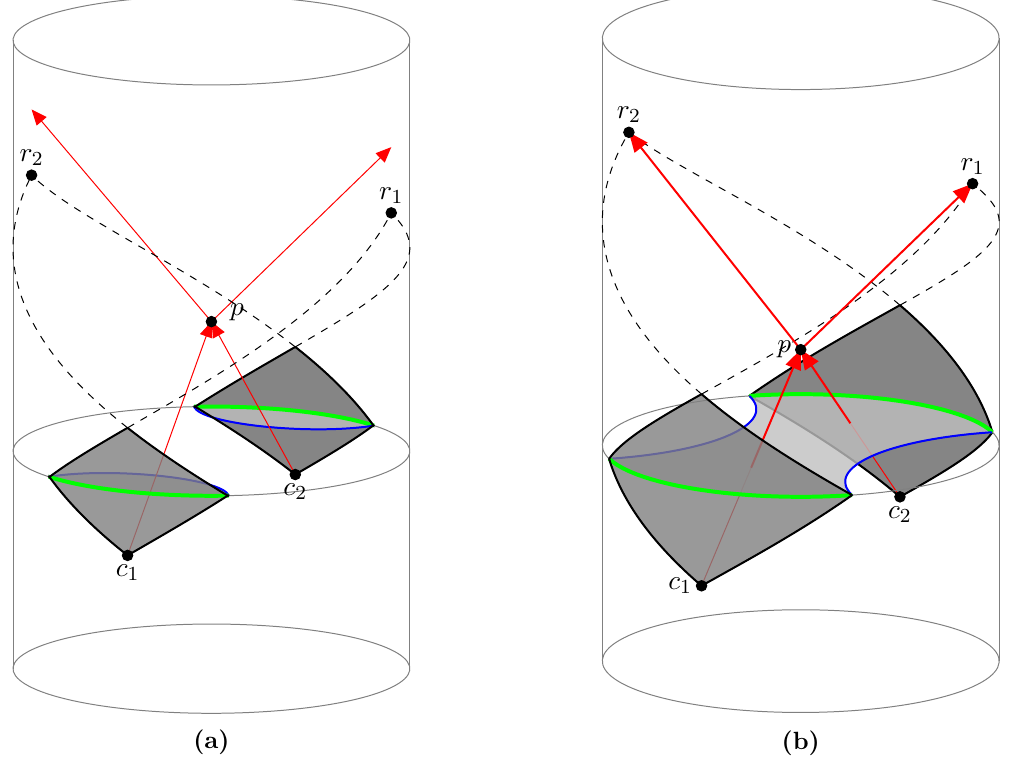
Figure 2. Combining our requirement on asymptotic quantum tasks, insights from quantum cryptography, and the Ryu-Takayangi formula we arrive at a precise result that applies to asymp- totically AdS spacetimes with holographic descriptions: whenever the minimal surface enclosing R 1 R 2 is given by the union of the minimal surfaces separately enclosing R 1 and R 2 , the intersection of four lightcones becomes non-empty. The regions R 1 and R 2 are shown in green. Their domain of dependence de(cid:12)nes the points c 1 and c 2 . Shooting null rays (dashed lines) from R 1 and R 2 de(cid:12)nes r 1 and r 2 . Then A ( R 1 R 2 ) = A ( R 1 ) [A ( R 2 ) implies that J (cid:0) ( r 1 ) \ J (cid:0) ( r 2 ) \ J + ( c 1 ) \ J + ( c 2 ) = ; , as occurs at left. When A ( R 1 R 2 ) 6 = A ( R 1 ) [ A ( R 2 ) then we may (cid:12)nd that the light cone intersection becomes non-empty. The implication is if and only if in the case of vacuum AdS. Details are given in section